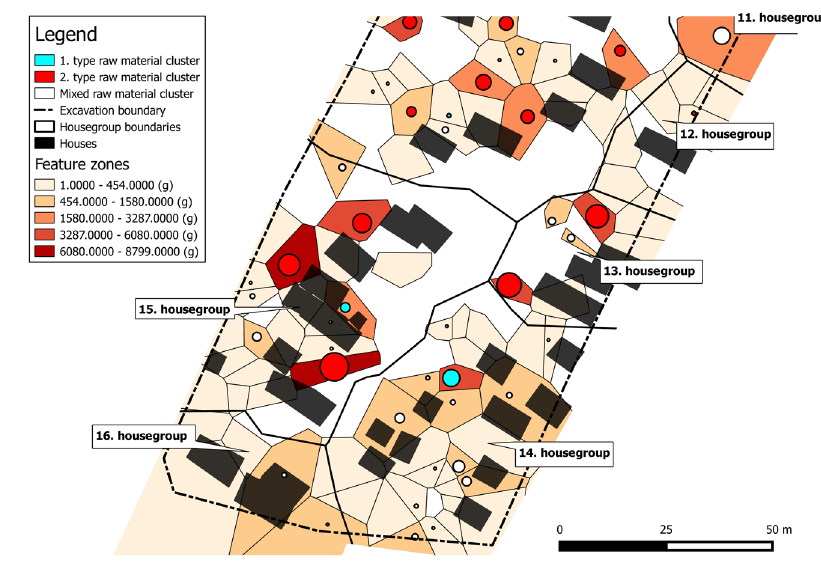
Figure 19: Houses, house groups, and activity zones in the southern section of the horizontal settlement Analyzing the raw material ratio clusters, it becomes clear that the house groups are similarly arranged. Two-thirds of the households belong exclusively to either to the southern raw material ratio cluster or to the northern raw material ratio cluster. House groups no. 1, no. 3, no. 6, no. 7, and no. 14 belong to the former cluster; three of these groups contain four houses and only one house group consists of more than ten buildings. These units are also spatially distinct—they can be found at the northwestern and southeastern corners of the excavation. House groups no. 2, no. 9, no. 10, no. 11, no. 13, and no. 15 belong to the northern raw material ratio cluster. Three of them are smaller, two of them are bigger according to the numbers of their buildings. They are situated in the northeastern to the southwestern corner of the excavated part of the settlement. Some of the units contain a mixture of features, which means that they belong to both ratio clusters—namely nos. 5 and 8. The rest of the house groups follow different raw material ratios, or they contain an insufficient amount of chipped material—namely house groups no. 4, no. 12 and no. 16. The last point relates to the question of internal chronology. Having 74 AMS dates, mainly from graves all around the settlement, four phases were created after calibration (Fig. 20). The first is 4870/4850– 4855/4790 cal BC, the second 4850/4770–4830/4725 cal BC, the third 4800/4720–4770/4660 cal BC and the fourth 4730/4655–4665/4625 cal BC. Unfortunately, there are only seven features that are dated precisely and contain a significant amount of chipped stones. Features nos. 44 and 997 from the first phase, nos. 916 and 932 from the second phase, and nos. 546, 932, and 966 from the third phase. Their detailed analysis is still pending, but the raw material composition did not indicate any differences or changes through time. Such a result is important because the observed raw material ratio clusters cannot be interpreted as signs of a temporal shift in raw material acquisition. With only two exceptions, every house group contains graves with data from at least two phases. Five house groups can be associated with the earliest phase—namely nos. 2, 7, 13, 15, and 16. The second phase can be associated with house groups nos. 1, 3, 5, 9, 10, 14, and 15. The third phase is the most numerous, as only one house group—no. 2—does not show any data from this period. The fourth phase has a wide distribution as well—with the exception of house groups nos. 3, 6, 8, 13, and 16, it can be found in numerous